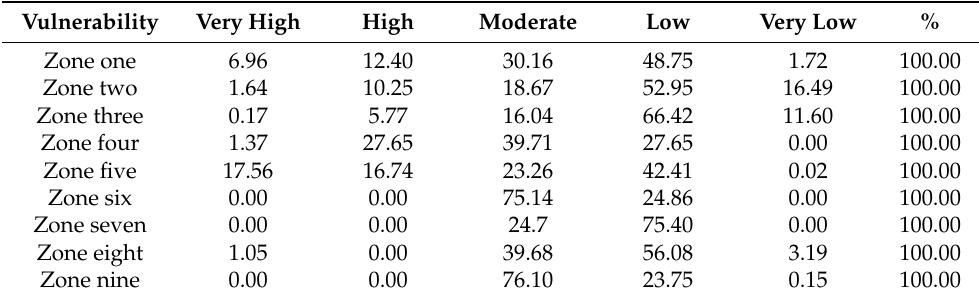
Table 4. Percentage of land cover by earthquake vulnerability of municipalities (zones) in Tabriz, Iran.